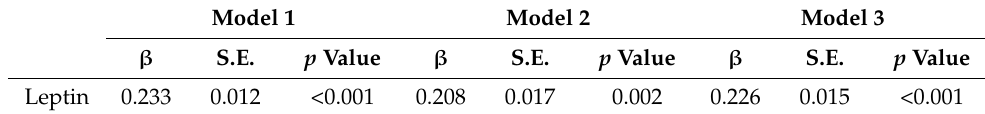
Table 3. Linear regression between leptin and the HOMA-IR index.